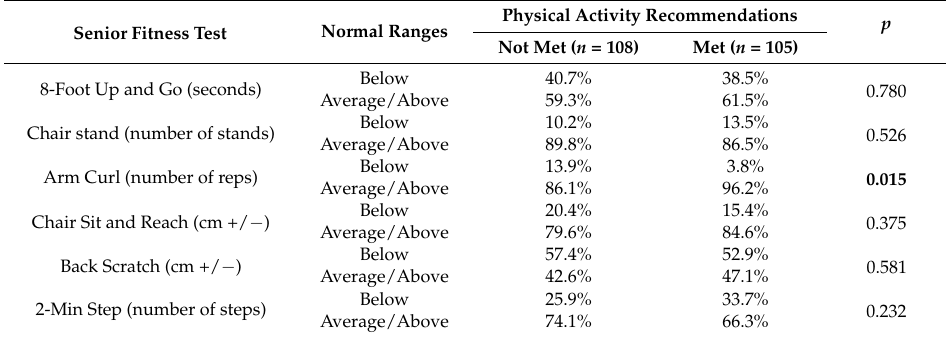
Table 3. Results of the Senior Fitness Test (SFT) according to norm for the age among women who met and did not meet the physical activity